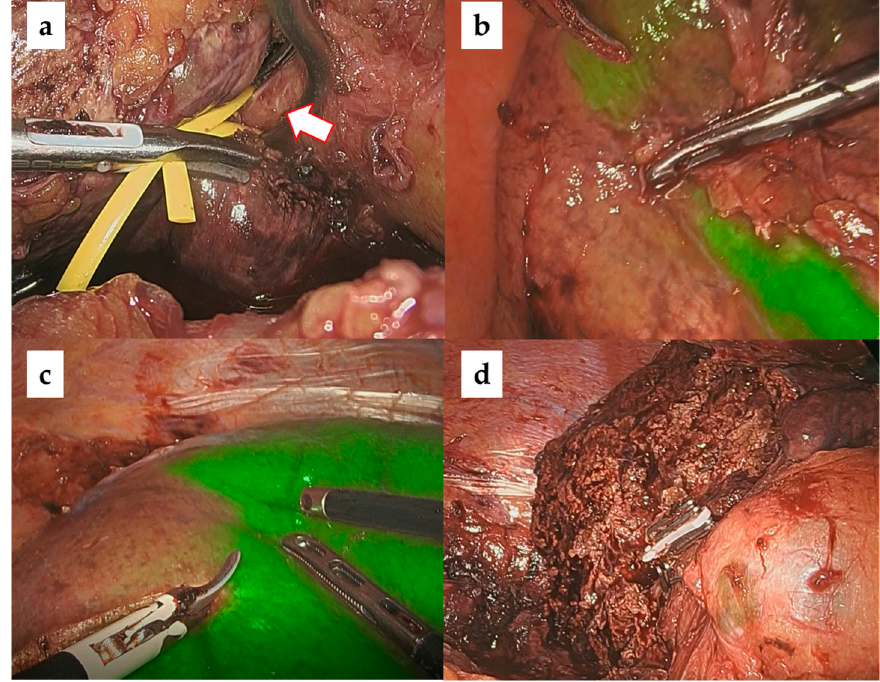
Figure 3. Laparoscopic right posterior sectionectomy with ICG negative staining. ( a ) Securing the main trunk of the right posterior branch of Glisson (arrow). ( b ) ICG demarcation line (dorsal). ( c ) ICG demarcation line (ventral). ( d ) Liver cut surface.